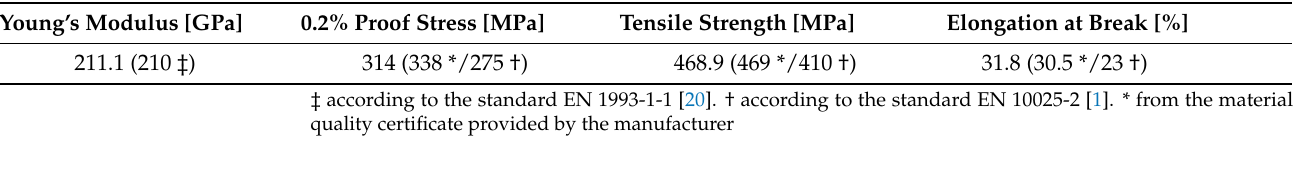
Table 1. Mechanical properties of 12 mm thick hot-rolled plate made of S275JR+AR structural